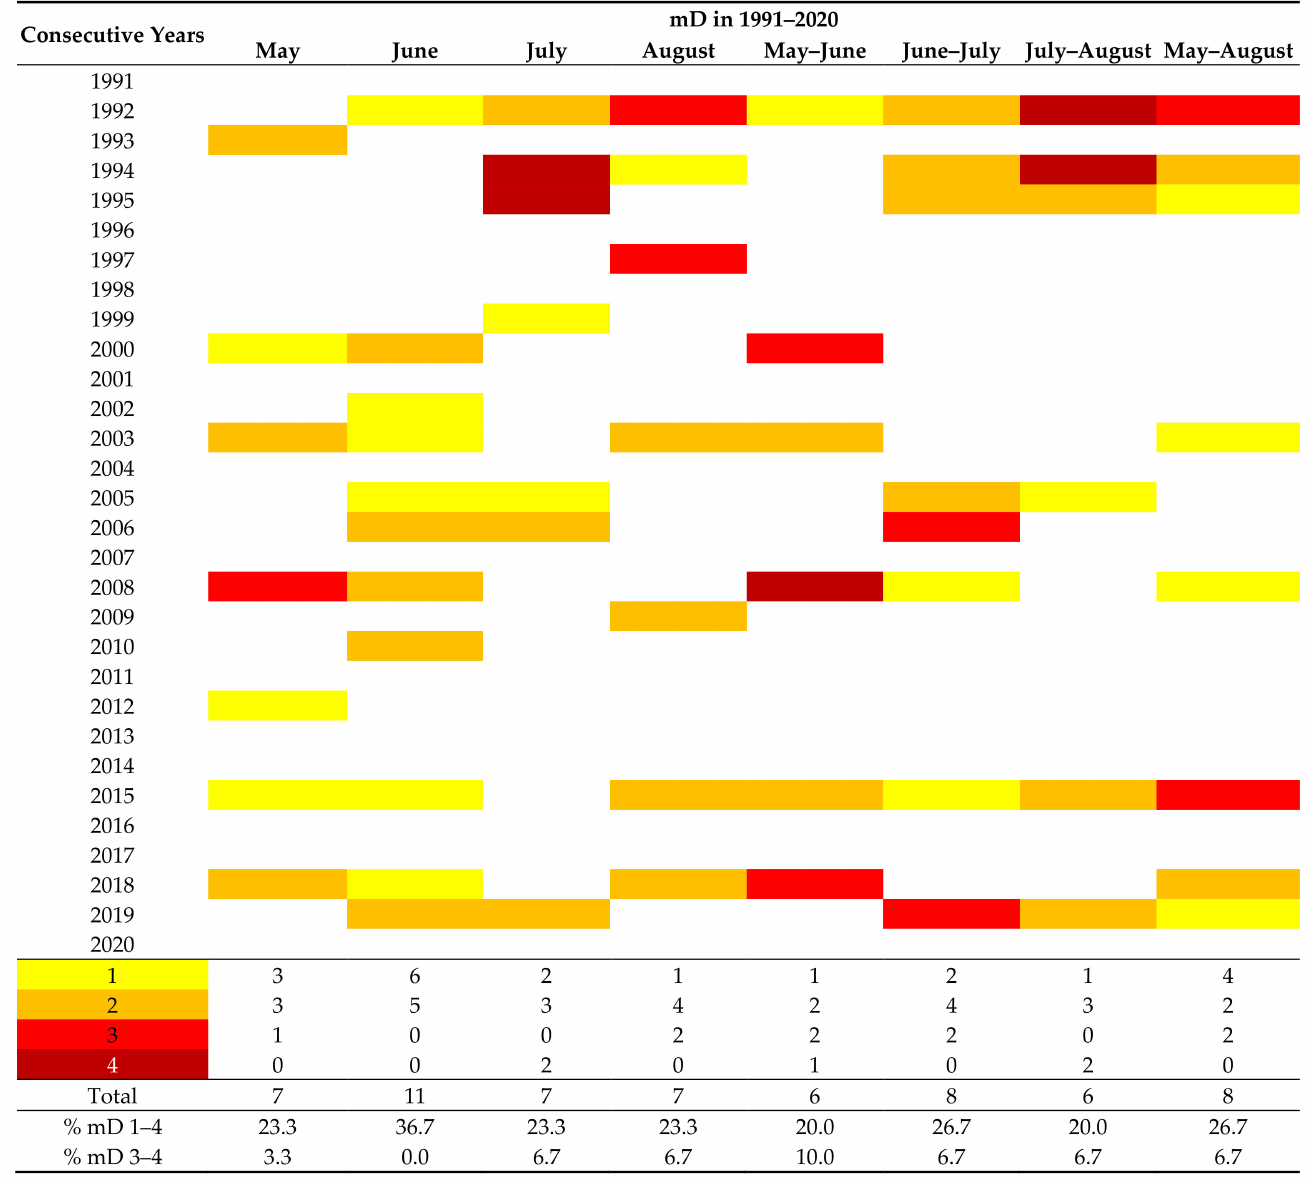
Figure 2. Occurrence of meteorological droughts (mD) determined on the base of the SPI during the period of active plant growth and development (May–August) in the region of Bydgoszcz in 1991–2020. The colors illustrate the level of drought